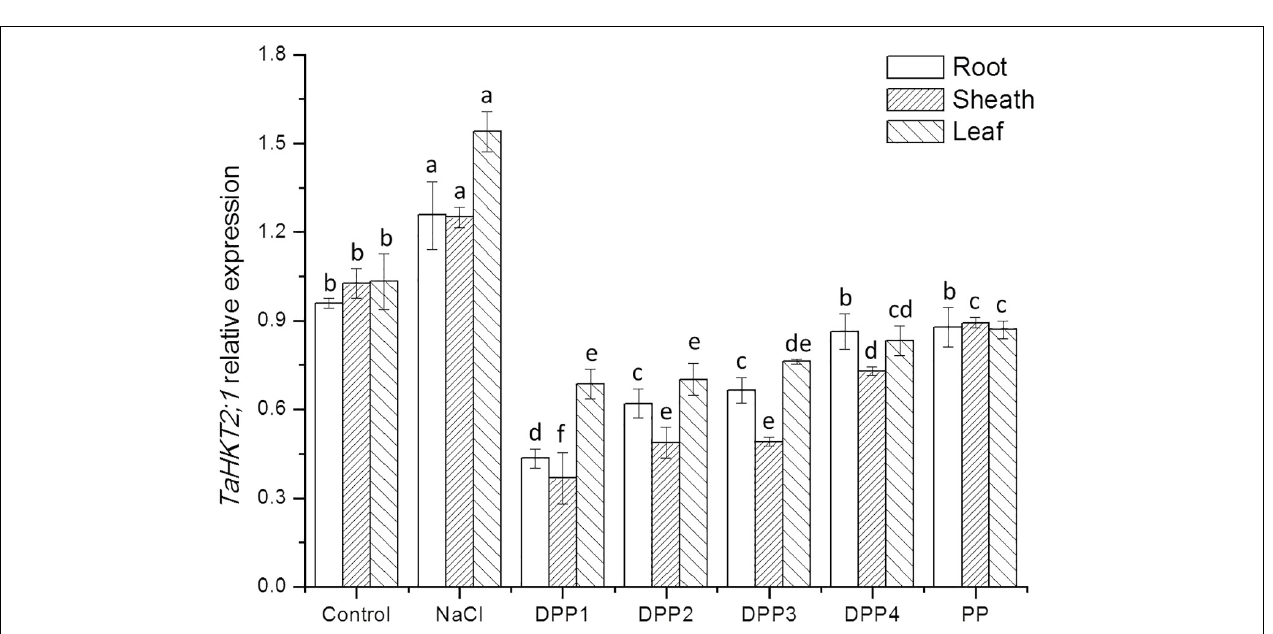
FIGURE 8 | Effect of four degraded (DPP1,2,3,4) and natural polysaccharides (PP) from P. yezoensis on K + /Na + ratio of root, sheath, and leaf in wheat seedlings. Values are the mean ± SD of three replicates. Different letters indicate significant differences at P < 0.05.